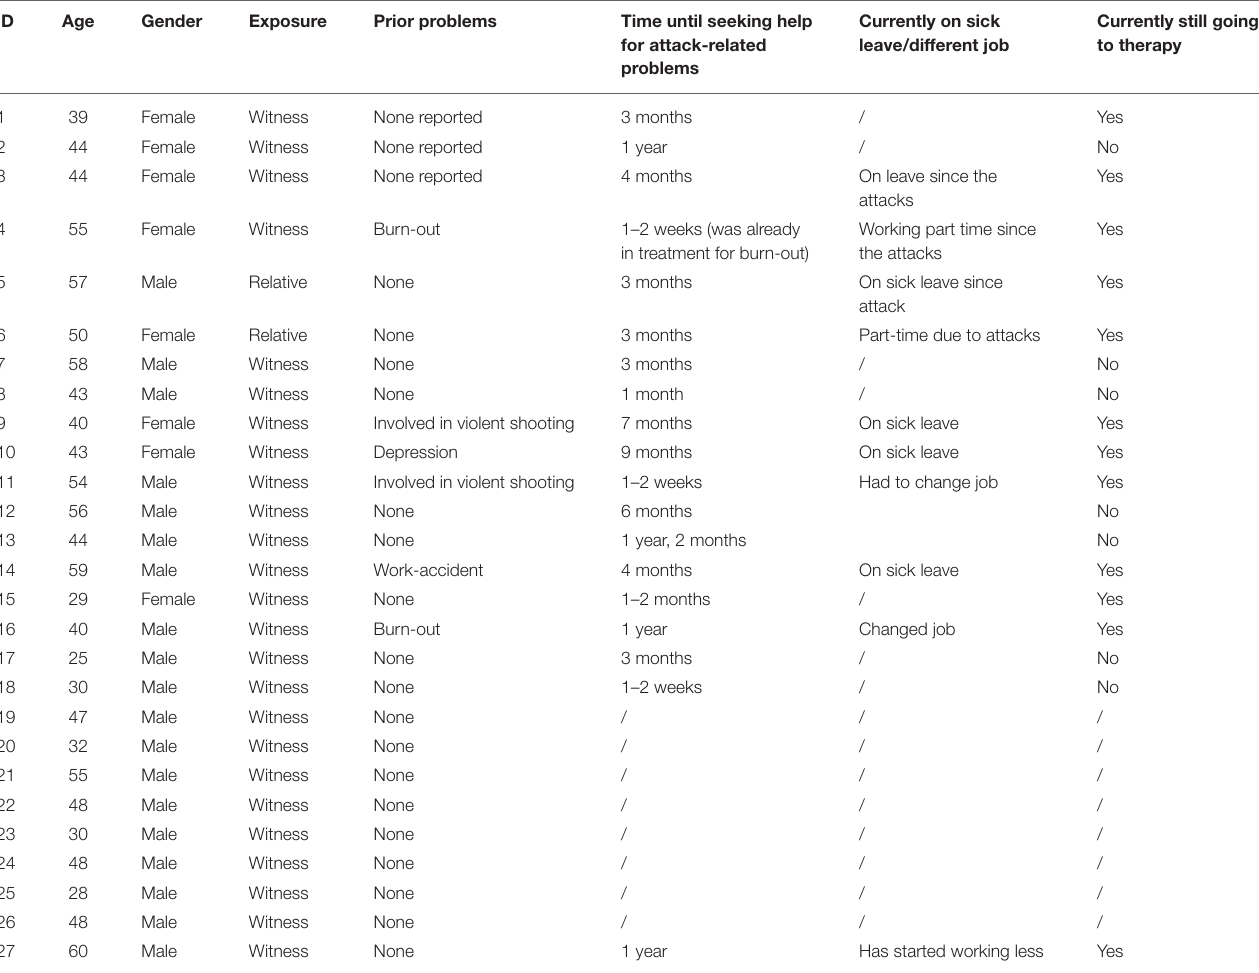
TABLE 1 | Characteristics of sample ID, age, gender, profession, prior problems, and time until seeking